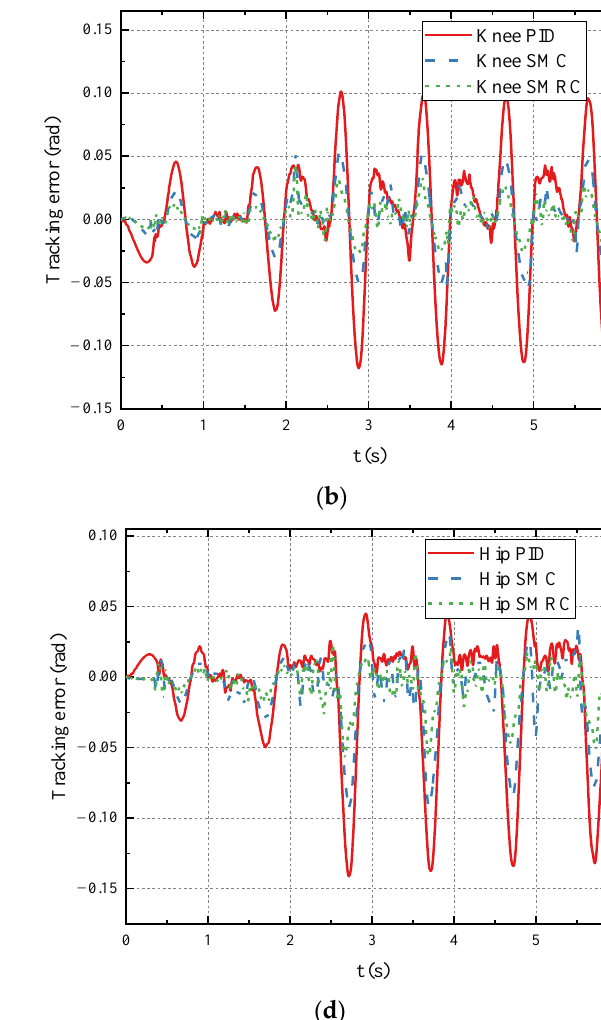
- Table 6. Main parameters of controllers in the hip joint. Controller 0.95 Table 7. Tracking error analysis. Control